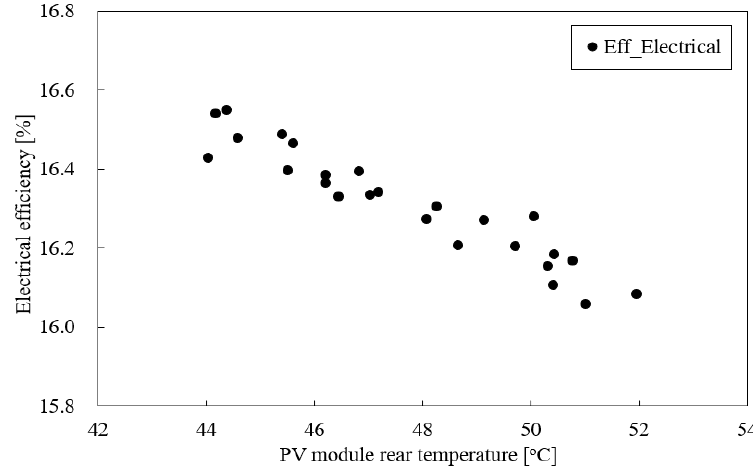
Figure 8. Electrical efficiency by PV module rear temperature.